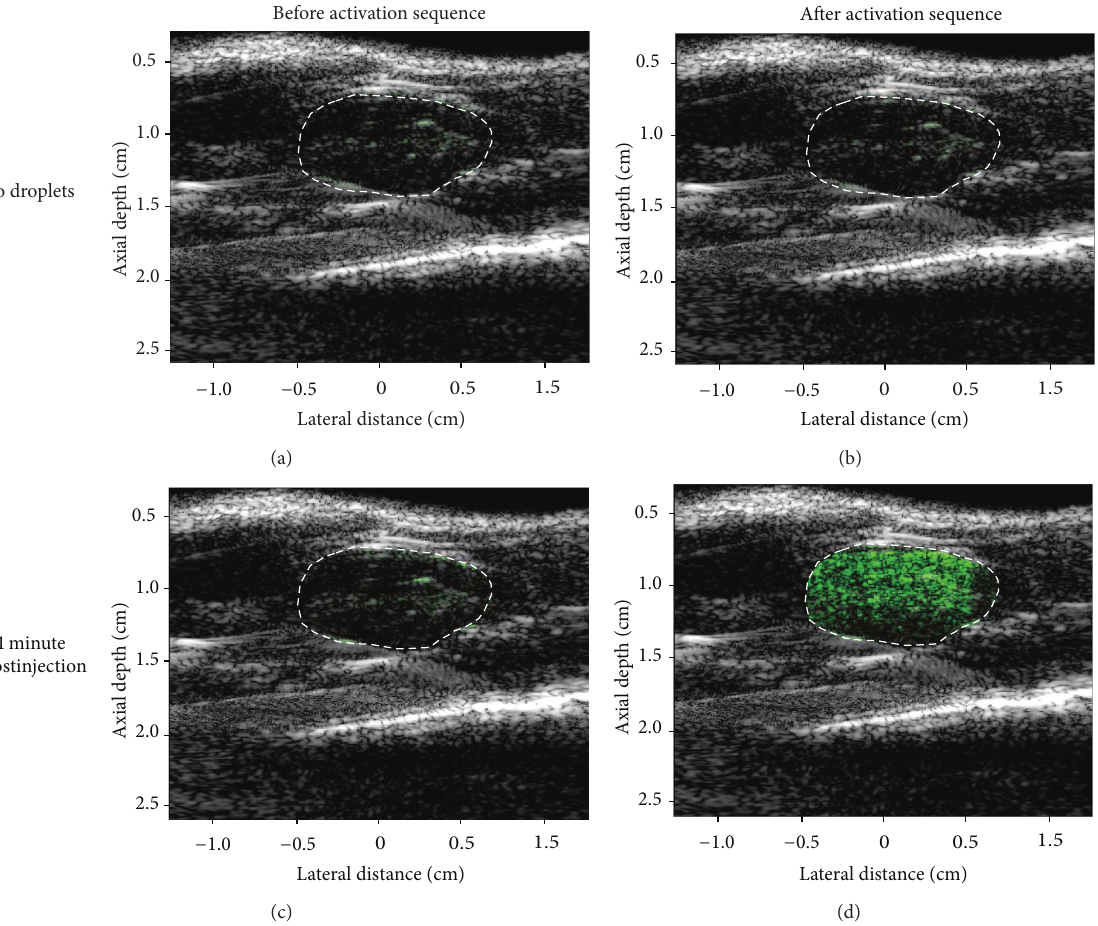
Figure 14: Overlays of contrast-specific intensity (green scale) and traditional B-mode (grey scale) ultrasound scans within the region of interest (white dotted line). When no droplets are present (top row), very little contrast is present before (left) and after (right)the vaporization pulse sequence. When a bolus of OFP droplets is injected, no significant increase in contrast is observed before the activation sequence (bottom row, left), but once the activation sequence is delivered a high level of contrast is visible in the region of the kidney (bottom row, right)—indicating conversion of the droplets to form highly echogenic microbubbles. Unpublished